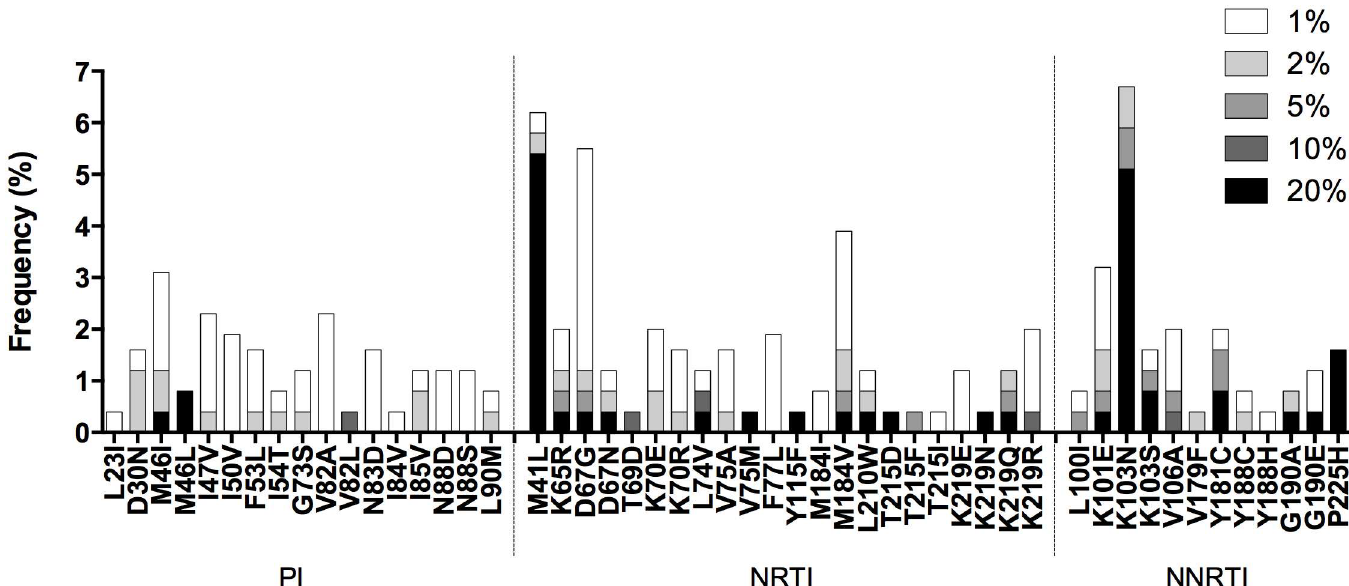
Fig 2. Surveillance drug resistance mutation frequency at different detection sensitivity thresholds. Drug resistance mutation frequency was determined at different thresholds using next generation sequencing as explainedin Methods. Cumulative frequency for each mutation is shown. Only surveillance drug resistance mutations are shown, and are classified by drug class.